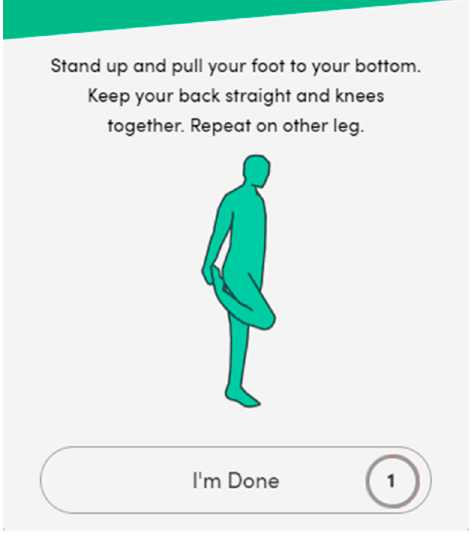
Figure 1. Example of nudge ‘doing card’ delivered during the intervention.